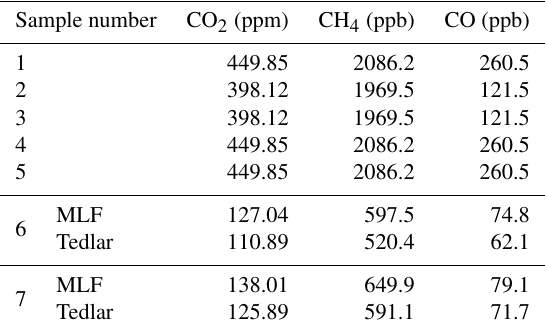
Table 2. A total of seven sampling bags of each type (Tedlar and MLF) were prepared with the mole fractions presented below. Sam- pling bag nos. 6 and 7 were filled with cylinder air and were sub- sequently diluted using nitrogen. The results of the CRDS analysis directly after measurement are presented for those